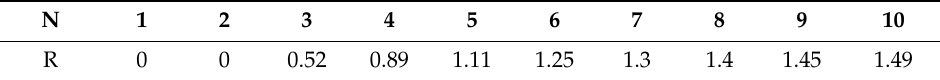
Table 7. Random Stability